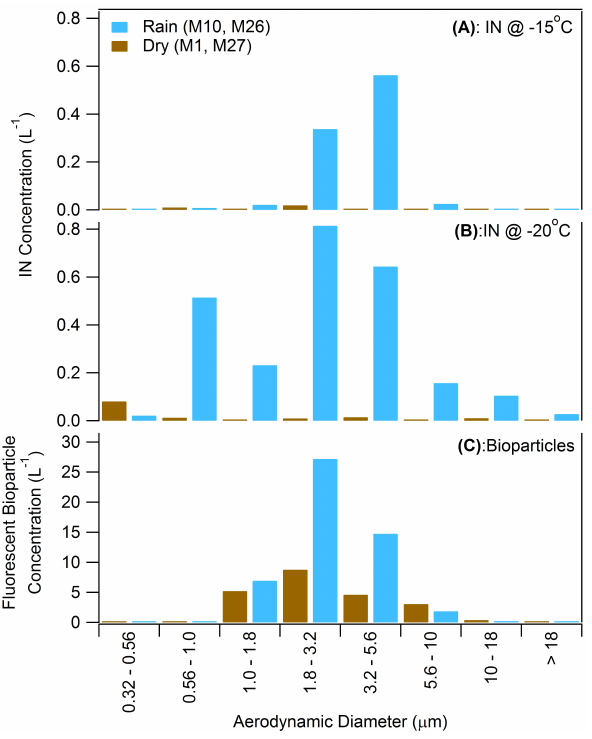
Fig. 4. Size distributions of ice nuclei observed in microscopic IN activation experiments (A) at − 15 ◦ C and (B) at − 20 ◦ C for aerosol impactor samples collected during dry periods and rain events. (C) Size distribution of bioparticles measured by UV-APS during the same periods. See SOM Sect. S1.4.1.1 for sampling